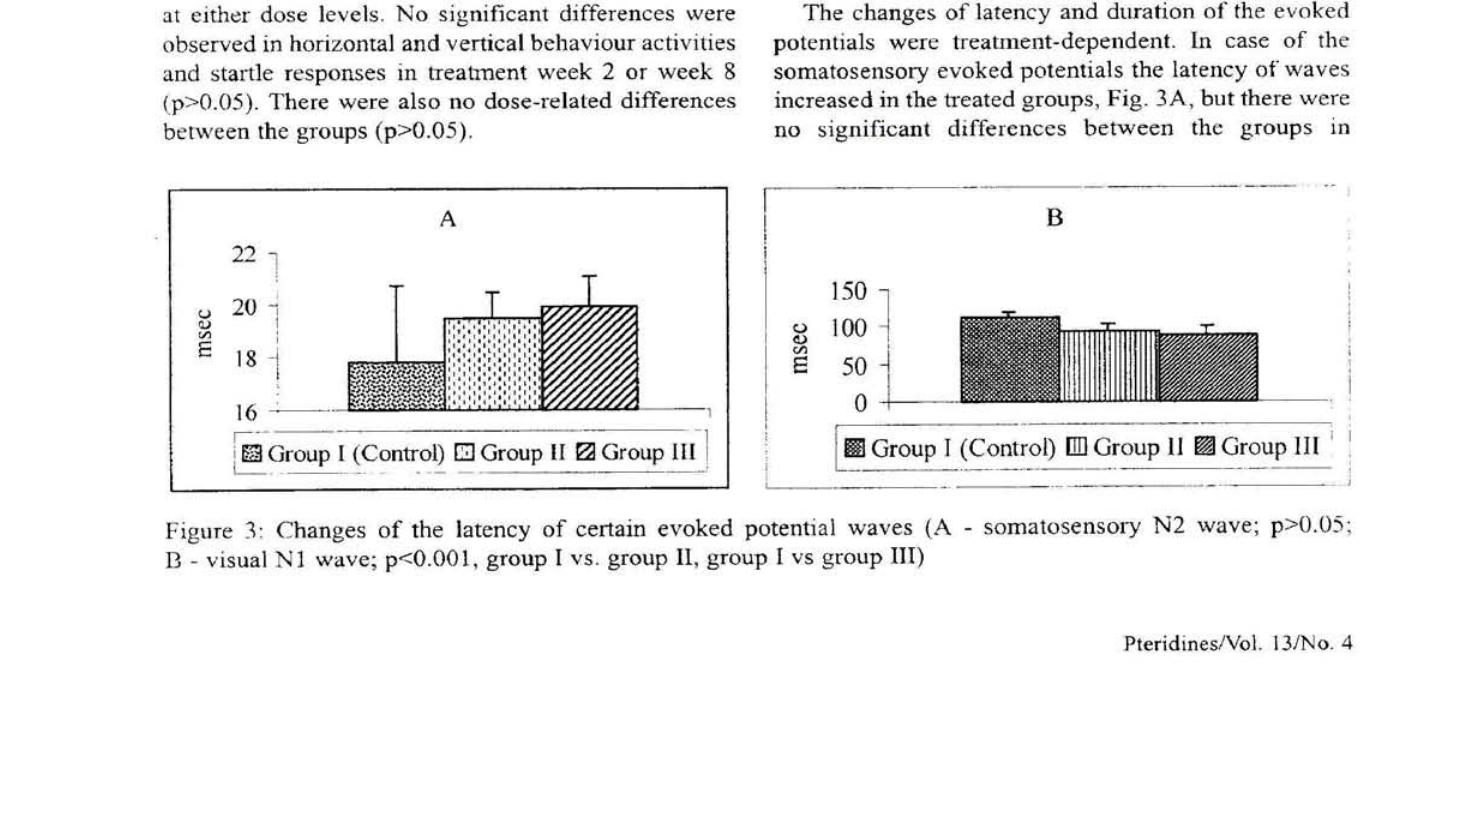
Figure 3: Changes of the latency of certain evoked potential waves (A - somatosensory N2 wave; p>0.05; Β - visual N1 wave; p<0.001, group I vs. group II, group I vs group III)